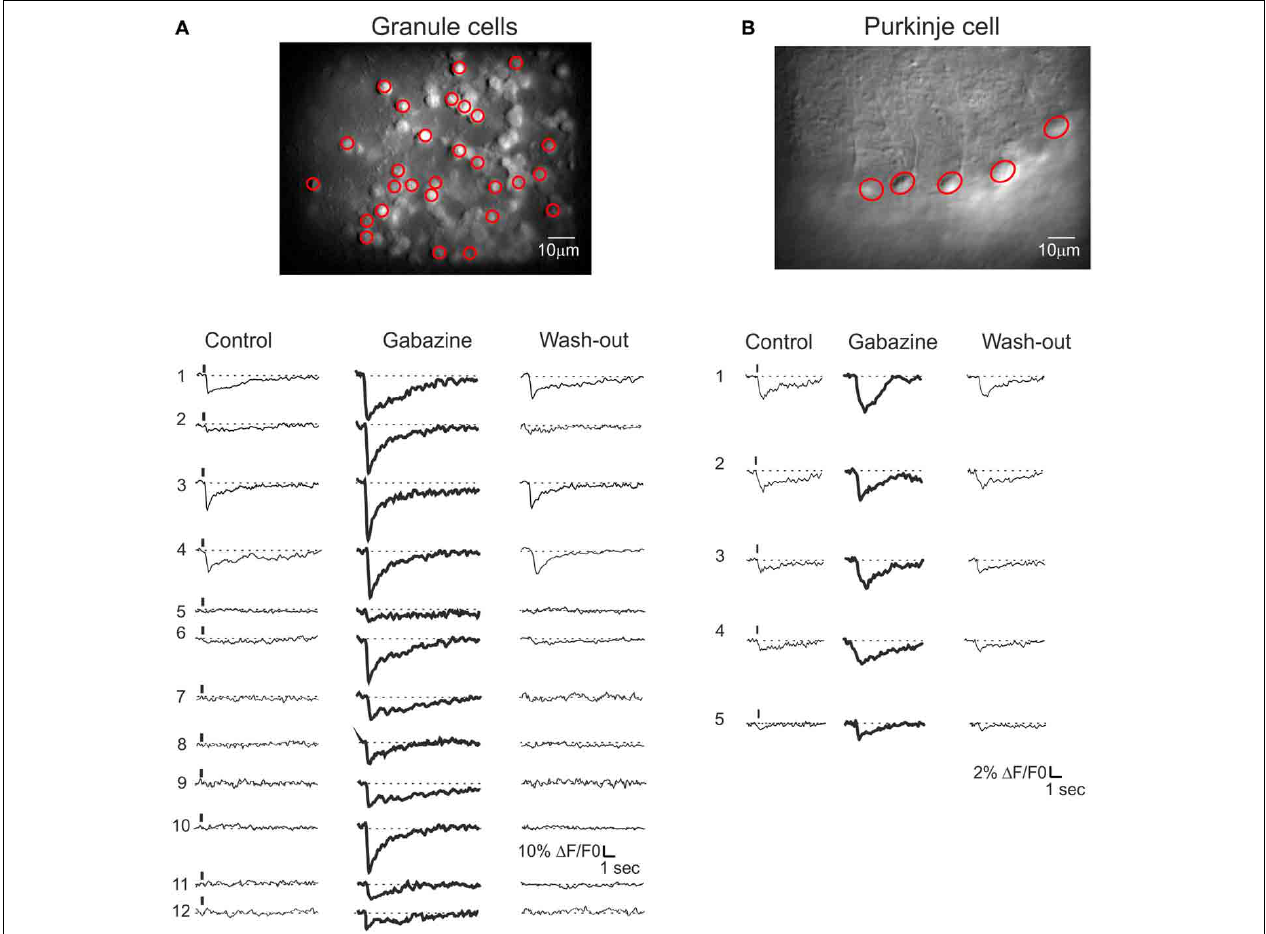
FIGURE 8 | Cerebellar circuit responses II: multi-neuronal activity patterns. Activation of the GrC and PC populations ina cerebellar slice bulk-loaded with Fura-2AM. All data were taken from the same experiment but the field of view had to be changed in order to cover the granular layer and molecular layer subfields. The calcium responses were elicited by 10 pulse- 50Hz mossy fiber burst delivered at 0.1Hz. (A) Granular layer. Top , high magnification (40 × ) image showing fluorescent GrCs (circled in red are those recorded with the SLM-2PM). Bottom, example traces showing the responses of GrCs (those circled in red in the top image) to mossy fiber bursts. In control (left), only three GrCs (traces 1, 3, 4) respond to